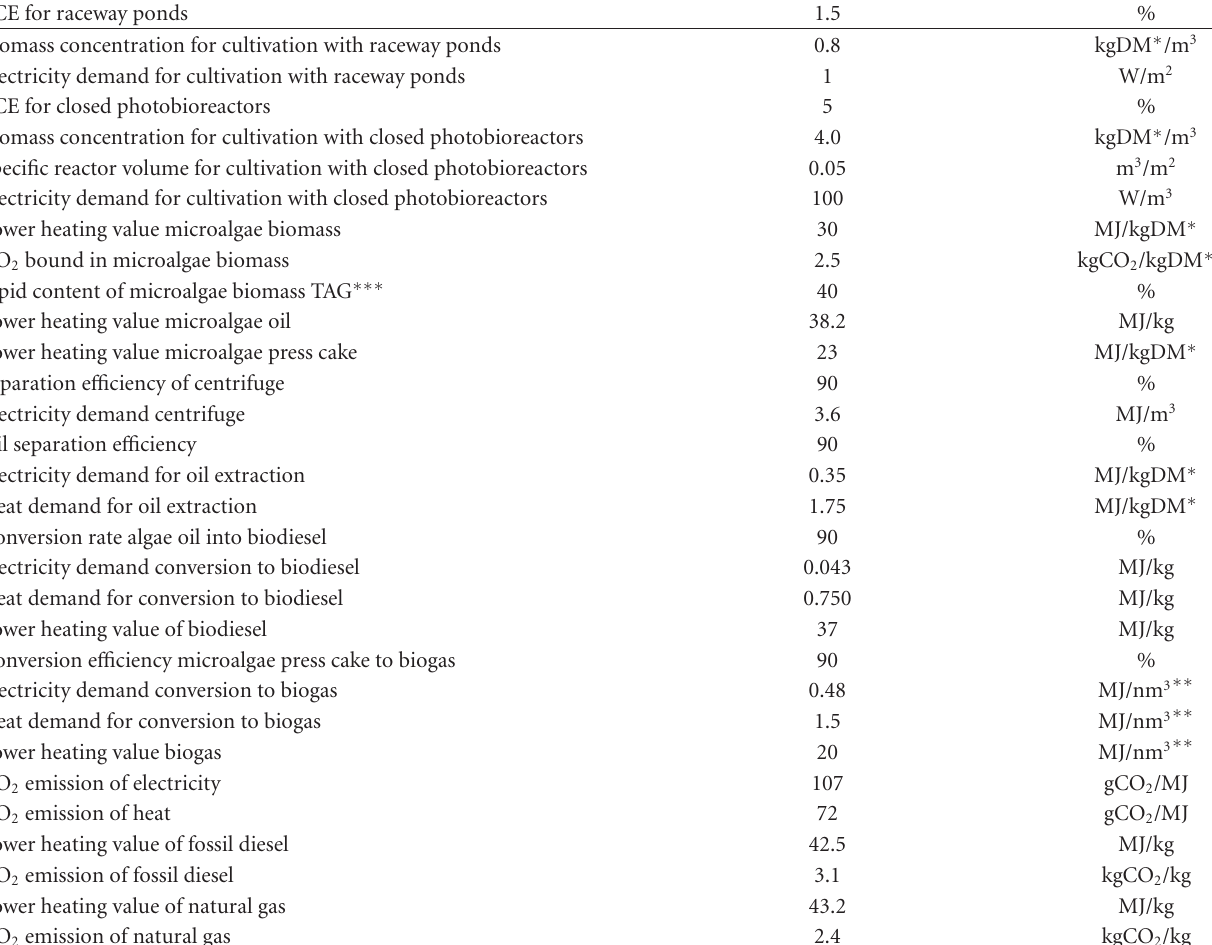
Table 8: Summary of estimated parameters assumed for calculation ([9, 26, 30–33] and own